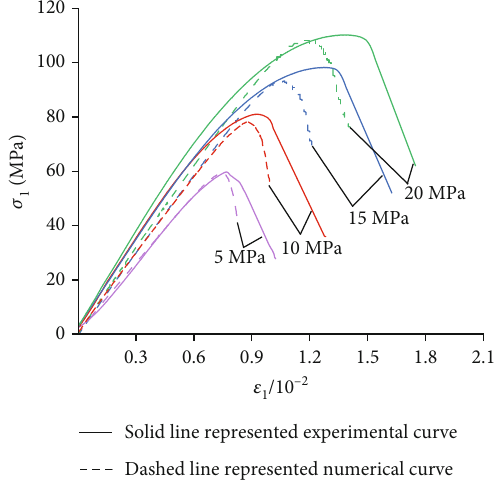
Figure 7: Numerical simulation curves of